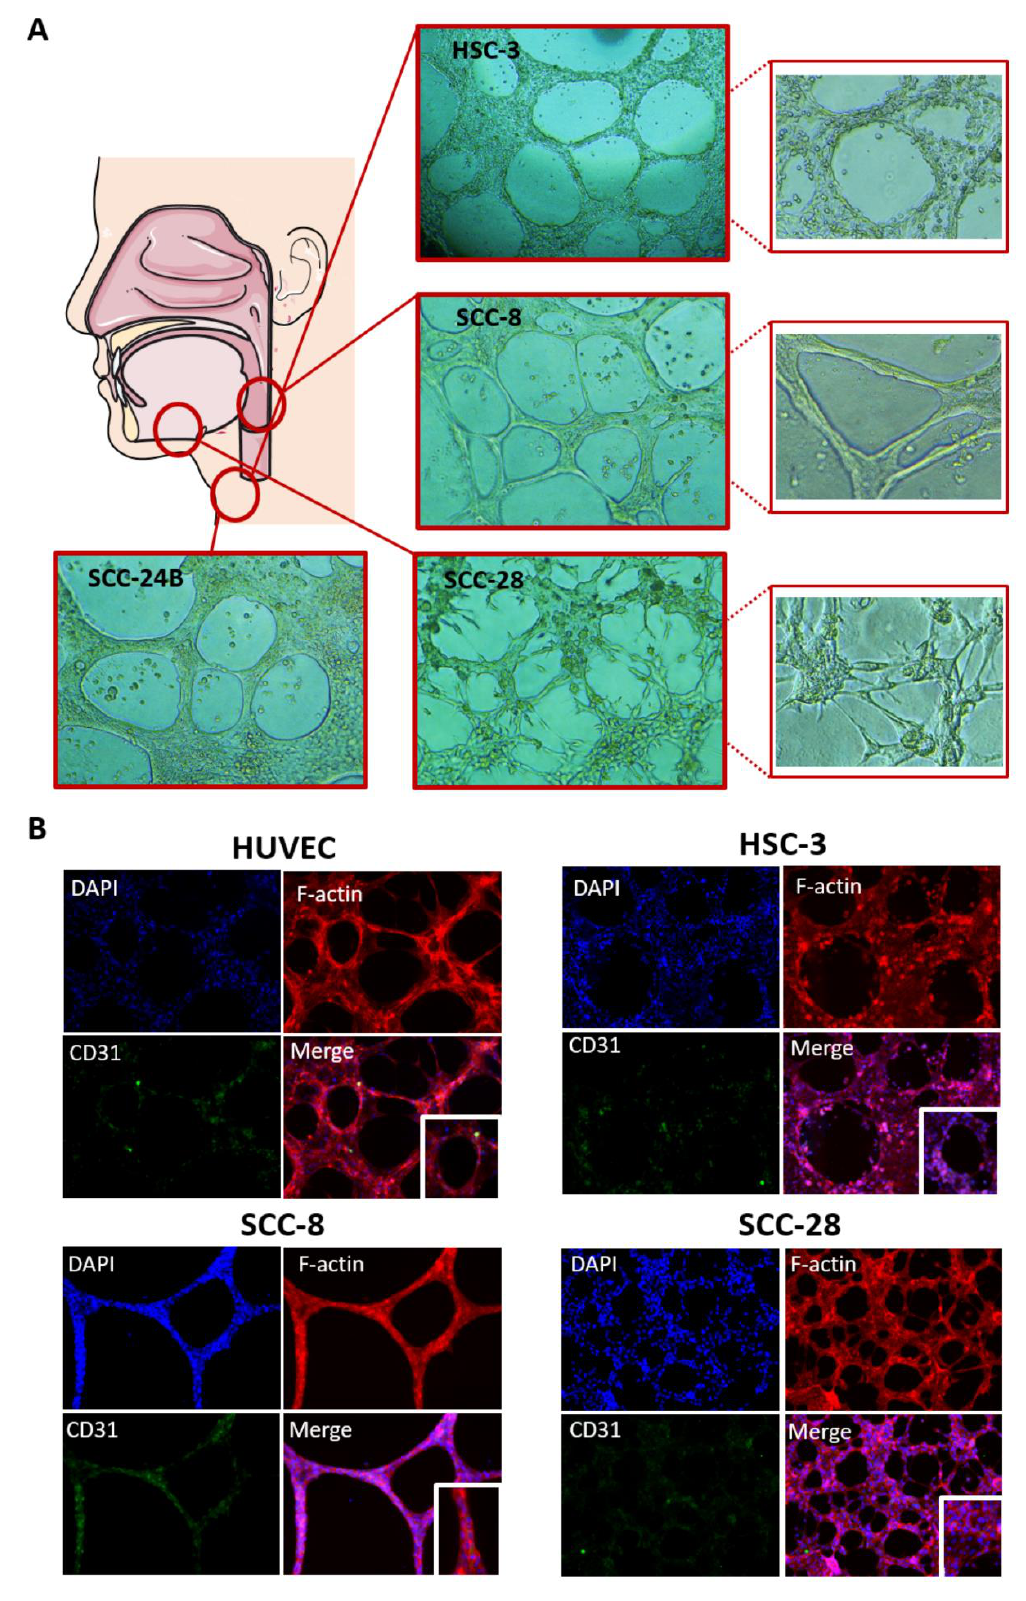
Figure 4. ( A ) Tumour cells show distinct morphological patterns of tubulogenesis in vitro. The highly metastatic tongue cancer cell lines (HSC-3 and SCC-24B) formed the classical “honeycomb-like” looping pattern, while the larynx-derived cell line (SCC-8) attained thinner branches with smoother capillaries. Evidently, cells from the floor of the mouth